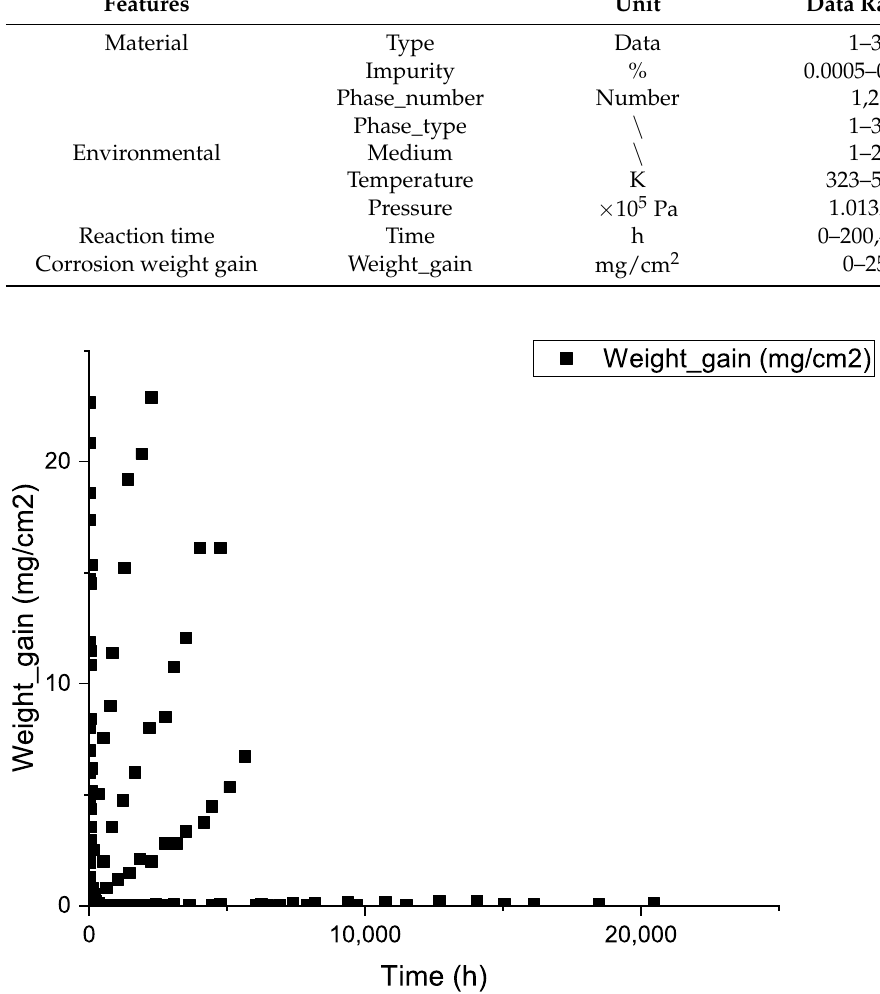
Table 1. Description of features in corrosion data.